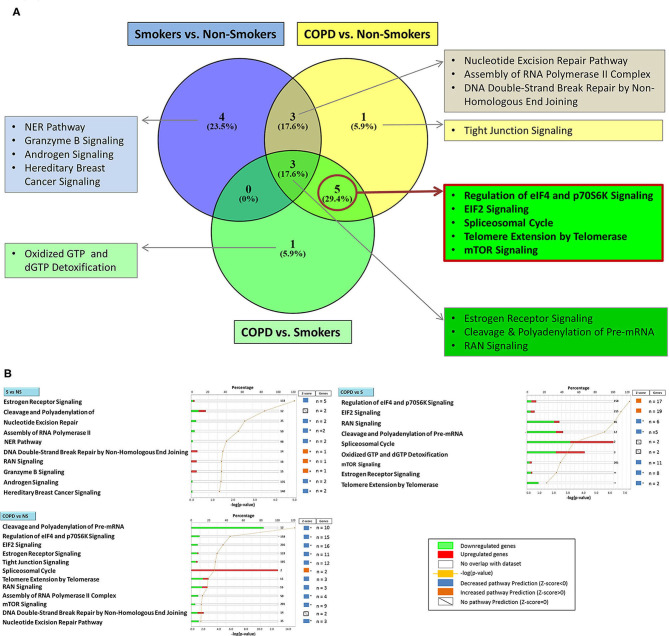
Genome Ontology analysis of mRBPs expression in small airway epithelium of stable COPD patients vs. non-smoking and smoking control subjects: involvement in established COPD pathogenic pathways. Ingenuity Pathway Analysis (IPA) of mRBP in COPD GSE5058 Dataset. (A) Venn diagram showing selective and shared canonical pathways among the group comparisons, calculated by Ingenuity Pathway Analysis (IPA) on DEGs for increased statistical power and listed as in Figure 3. In evidence (red lined rectangle) the pathways enriched in COPD vs. both NS and S control groups. (B) List of canonical pathways identified for each group comparisons. For each pathway, bargraphs indicate the number of RBP genes associated with the pathway (total number listed at the end of the bar) that were found up (red)- or down (green)-regulated in the dataset; z-score (on the right) predicts pathway repression (blue) or activation (orange) given by the expression profile (see Methods); far right: genes n = indicates number of regulated mRBP genes involved for each pathway (also listed in Table 2). * z-score ≥ |1|.